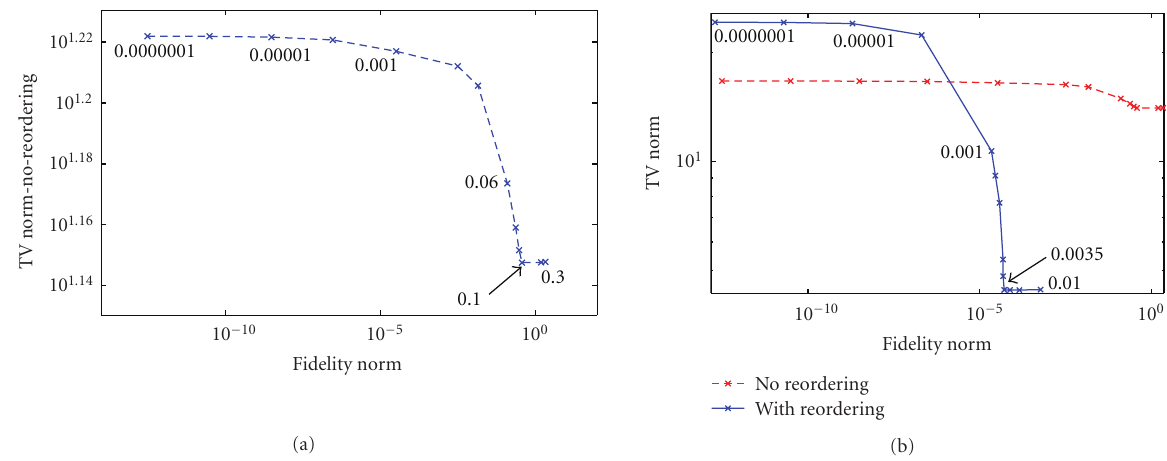
Figure 3: Comparison of optimal regularization weights without and with reordering. L -curves obtained for reconstruction of the nonsmooth signal in Figure 1(b) from R ∼ 2 Fourier data (a) without reordering and (b) with reordering overlaid by the L -curve in Figure 3(a).